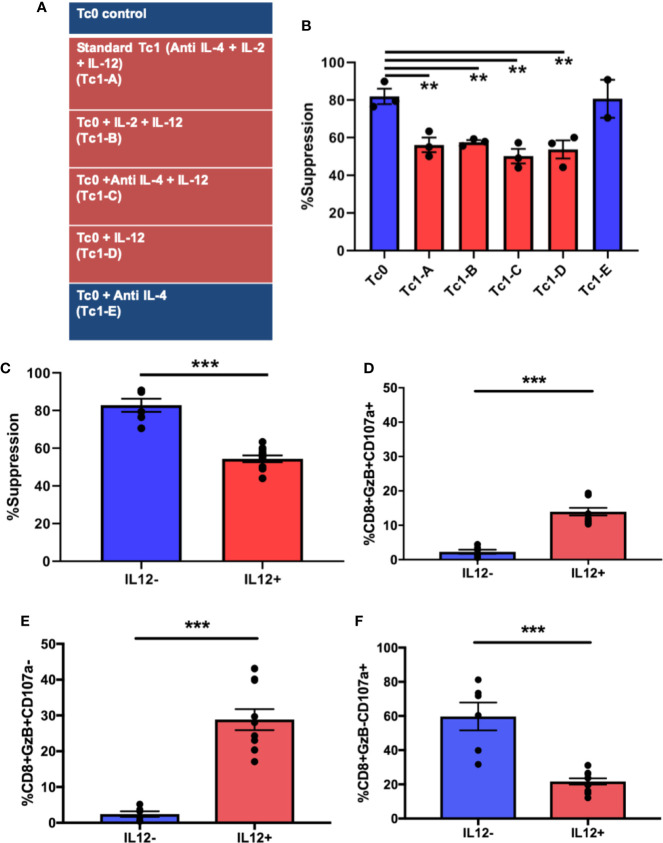
Exposure to IL-12 induces CD8+ T-cells characterized by suboptimal suppressive ability with dysregulated induction of cytotoxicity-related molecules. Six different culture conditions (A) were used to differentiate ex vivo-purified naïve CD8+ T-cells. On day 7, these Tc cells were assessed for suppressor ability against autologous CD4+CD25- T-cells. Panel (B) demonstrates %suppression for each of the conditions. Panel (C) shows the same data combined into two groups: cultures containing IL-12 (n = 12) and those without (n = 6). In parallel, cells from the 7-day cultures were stimulated with BioLegend Cell Activation cocktail with Monensin and anti-CD107a for 5h followed by intracellular staining for granzyme B. %GzB+CD107a+ dual positive CD8+ T-cells were quantified within the indicated groups (D), as were GzB+ (E) and CD107a+ (F) single-positive cells. **p < 0.01 and ***p < 0.001. (B) One-way ANOVA and (C–F) Mann-Whitney test.